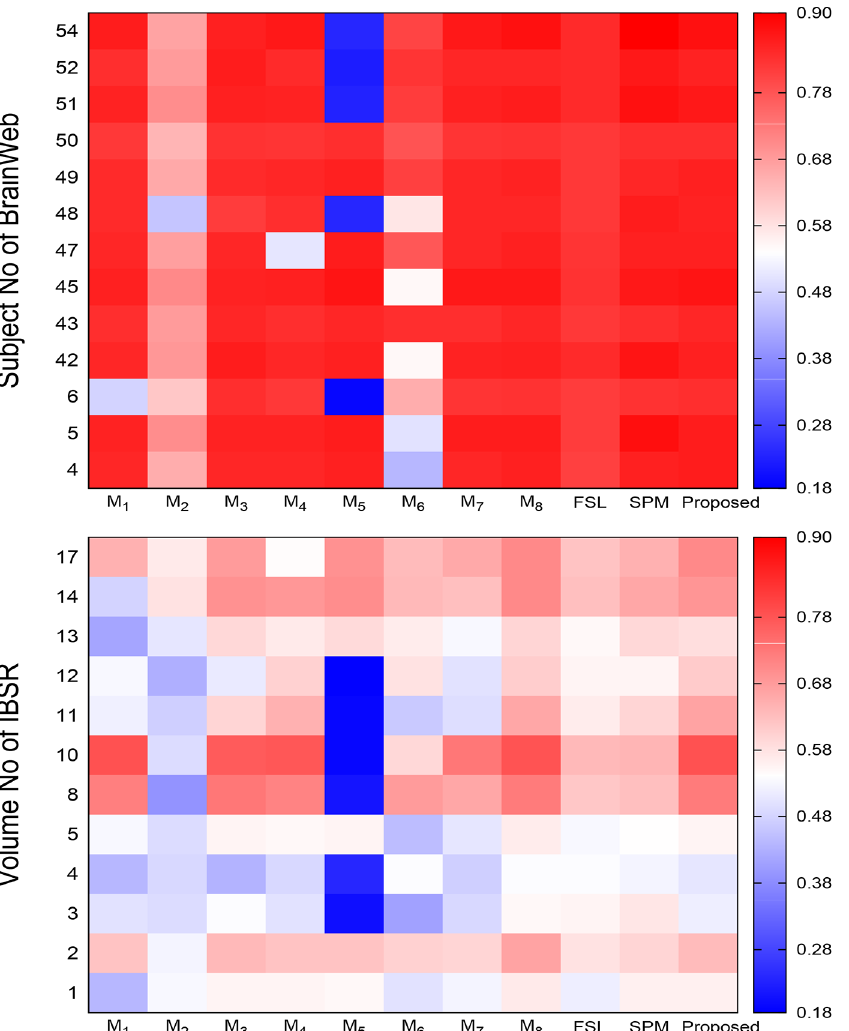
Fig 9. Heat maps obtained by different methods with respect to Jaccard index.